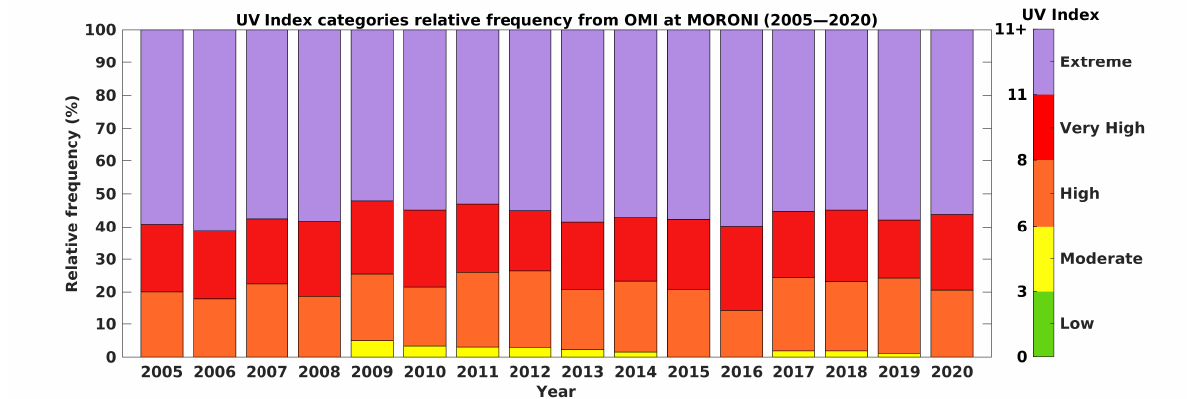
Figure 3. Annual relative frequency of UVI thresholds from UVI-OMI-AS-LN during 2005–2020 period. Colorbar represents UVI-OMI-AS-LN (UVI all-sky at local noon), according to color scale defined by OMS: Low UVI from 0 to 3 in green; moderate UVI from 3 to 6 in yellow; high UVI from 6 to 8 in orange; very high UVI from 8 to 11 in red, and extreme UVI above 11 in